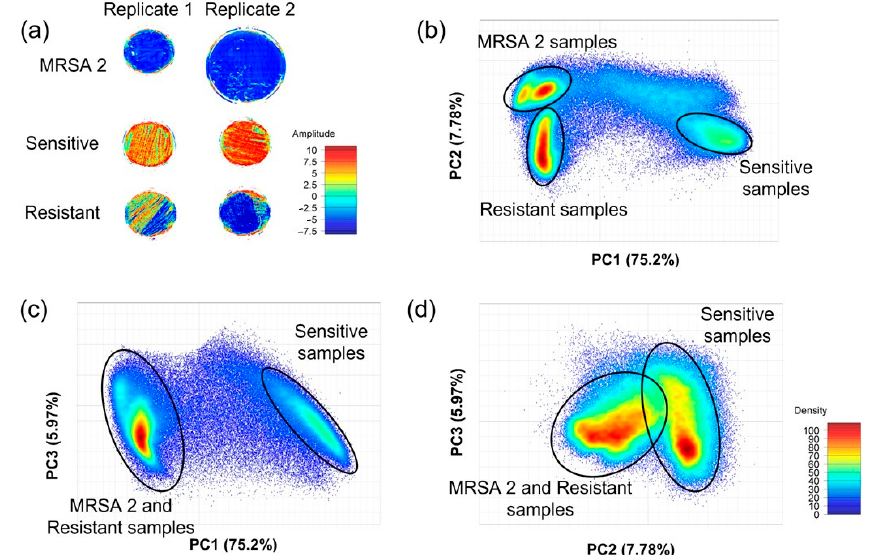
Figure 3. PCA image score showing the amplitude of the signal represented by the blue color in the image, where there is the presence of resistance to oxacillin/cefoxitin ( a ). Corresponding scoring graph (PC1 × PC2) shows groups of distinct pixels colored according to the density color scale ( b ); the same occurs on the scoring graph (PC1 × PC3) where all the resistant samples were gathered at the same point ( c ), and on the scoring graph (PC2 × PC3), the samples that contained resistance showed higher intensity than the sensitive sample ( d ).